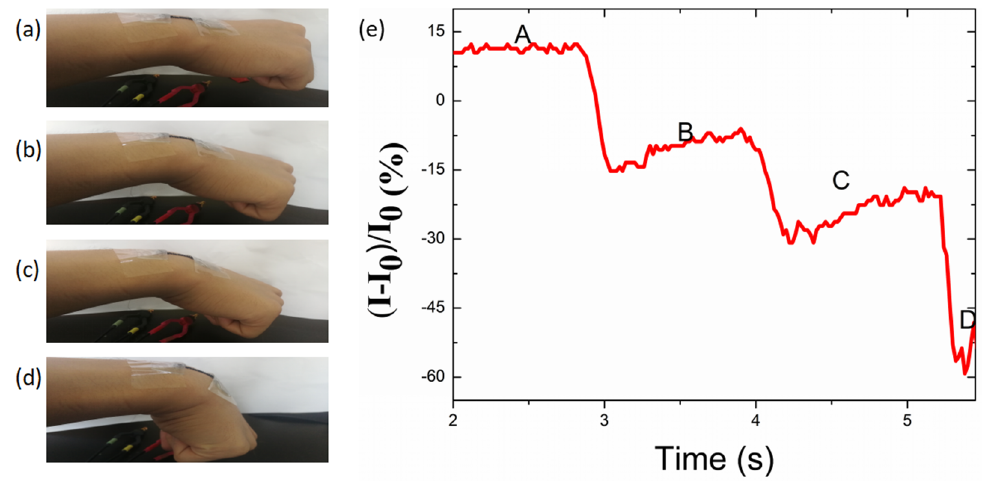
Figure 11. ( a – d ) Photograph of the TPU / graphene strain sensor with an intertwined-coil configuration Figure 11. ( a–d ) Photograph of the TPU/graphene strain sensor with an intertwined-coil configuration attached conformally to a volunteer’s wrist, with di ff erent bending angles. ( e ) A plot of the attached conformally to a volunteer’s wrist, with different bending angles. ( e ) A plot of the corresponding current variation in detecting di ff erent degrees of bending of the human wrist. corresponding current variation in detecting different degrees of bending of the human wrist.